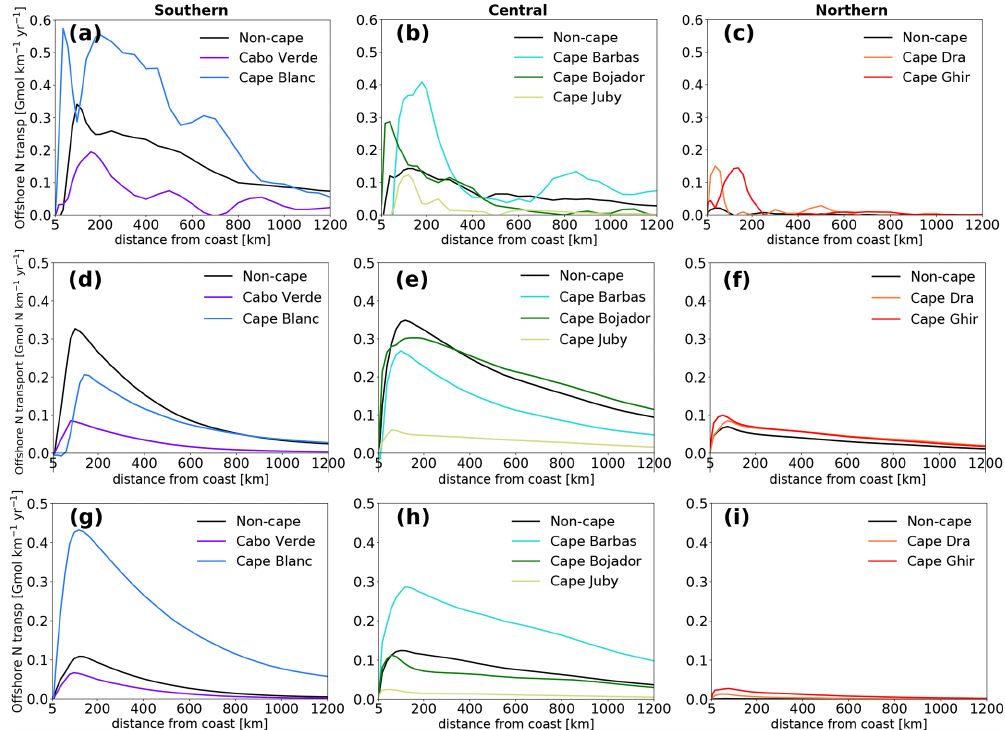
Figure 8. Enhancement of net offshore transport of nitrogen by capes. (a, b, c) Transport within the latitudinal span of each cape or non-cape area. Transport occurring within each latitudinal span is considered at any distance from the coast irrespective of the location of upwelling or coastal export. (d, e, f) Transport associated with locally upwelled water in each cape or non-cape coast. (g, h, i) Transport associated with non-locally upwelled water at each cape or non-cape area. Note that the transport is normalized by coastal length (divided by the length of the coast at the respective cape or non-cape